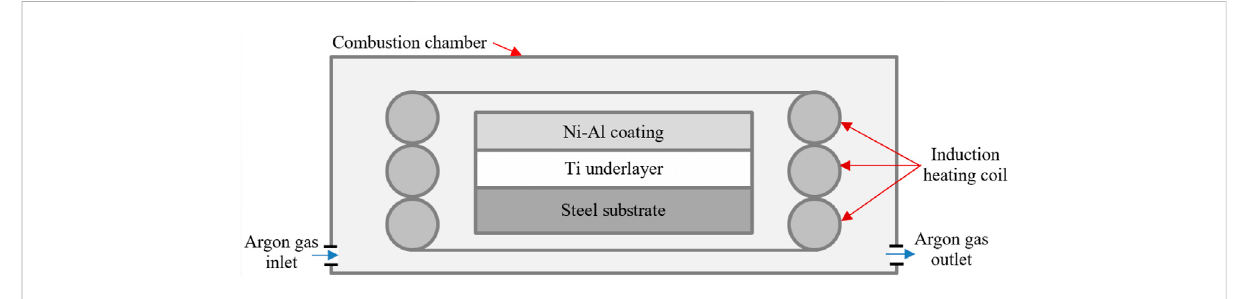
FIGURE 1 The schematic fi gure of combustion chamber containing induction heating.